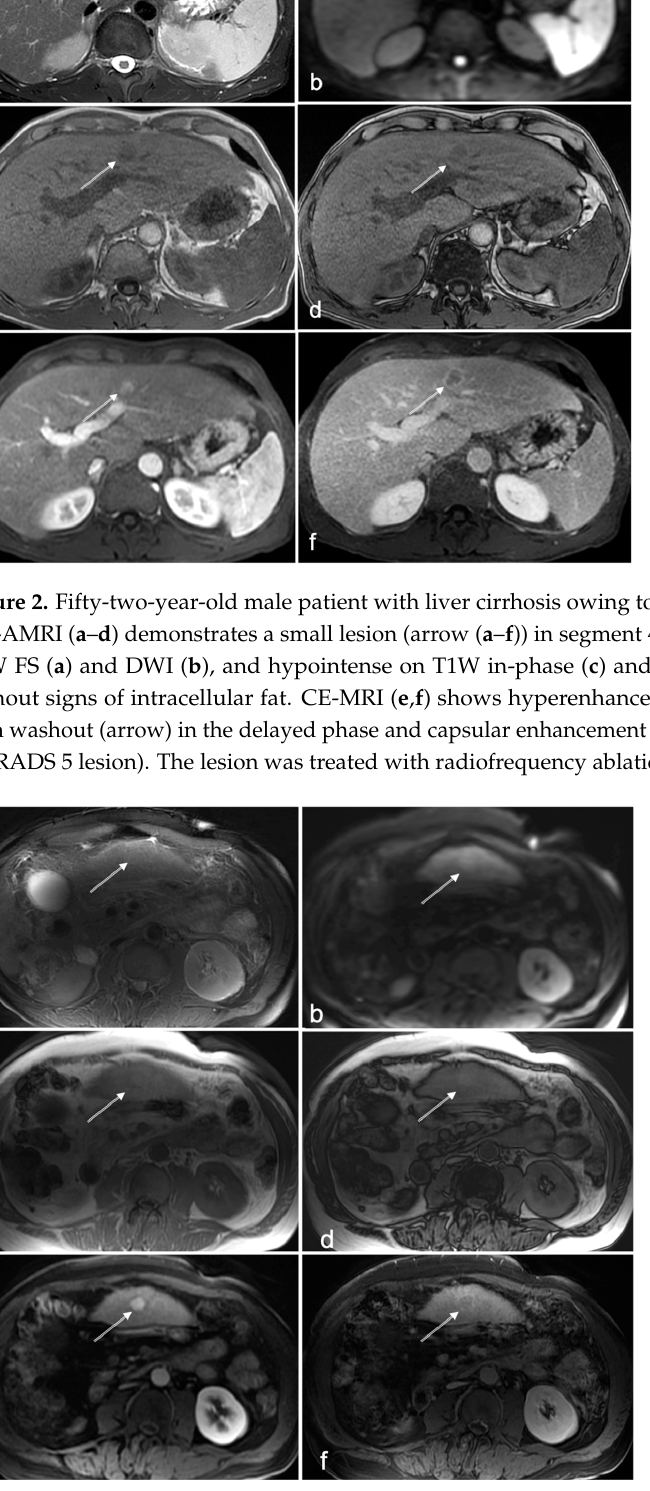
Figure 3. Seventy-six-year-old male patient with liver cirrhosis caused by NASH. On NC-AMRI initially, no lesion was noted by all three readers (i.e., missed lesion, location of the lesion marked with arrow on ( a – f )); axial T2W FS ( a ), DWI (b = 600 mm/s 2 ) ( b ), and T1W in-phase ( c ) and opposed- phase ( d ). On CE-MRI, a hyper enhancing lesion in segment 3 is clearly identified (arrow) on T1 arterial phase ( e ) with delayed washout and capsular enhancement ( f ), compatible with an Li-RADS 5 lesion. Upon review by consensus after data analysis, the readers agreed that the lesion was not discernable on T2W FS ( a ), and merely very slightly hyperintense on DWI ( b ) and T1W in-phase ( c ) and opposed-phase ( d ) images. It was concluded that the lesion was missed in this patient on NC- AMRI owing to a sub-optimal image quality of the left liver lobe with an overall lack of signal in- tensity on DWI. 3.2. HCC-Naïve Cases In HCC-naïve cases, diagnosis was correct in 87.2% (156/179) using majority vote. All three readers correctly scored 65.4% (117/179) of the patients as negative for HCC. In about one-eighth of the patients (12.8%; 23/179), two readers qualified a benign lesion as positive (i.e., possible, probable, or confident) for HCC, and about one-fifth of the patients with benign lesions (21.8%; 39/179), while one reader scored a benign lesion as positive for HCC (Table 4). Examples of such ‘false positive’ lesions are (atypical) hemangiomas that are for example just mildly hyperintense on T2W images (Figure 4).